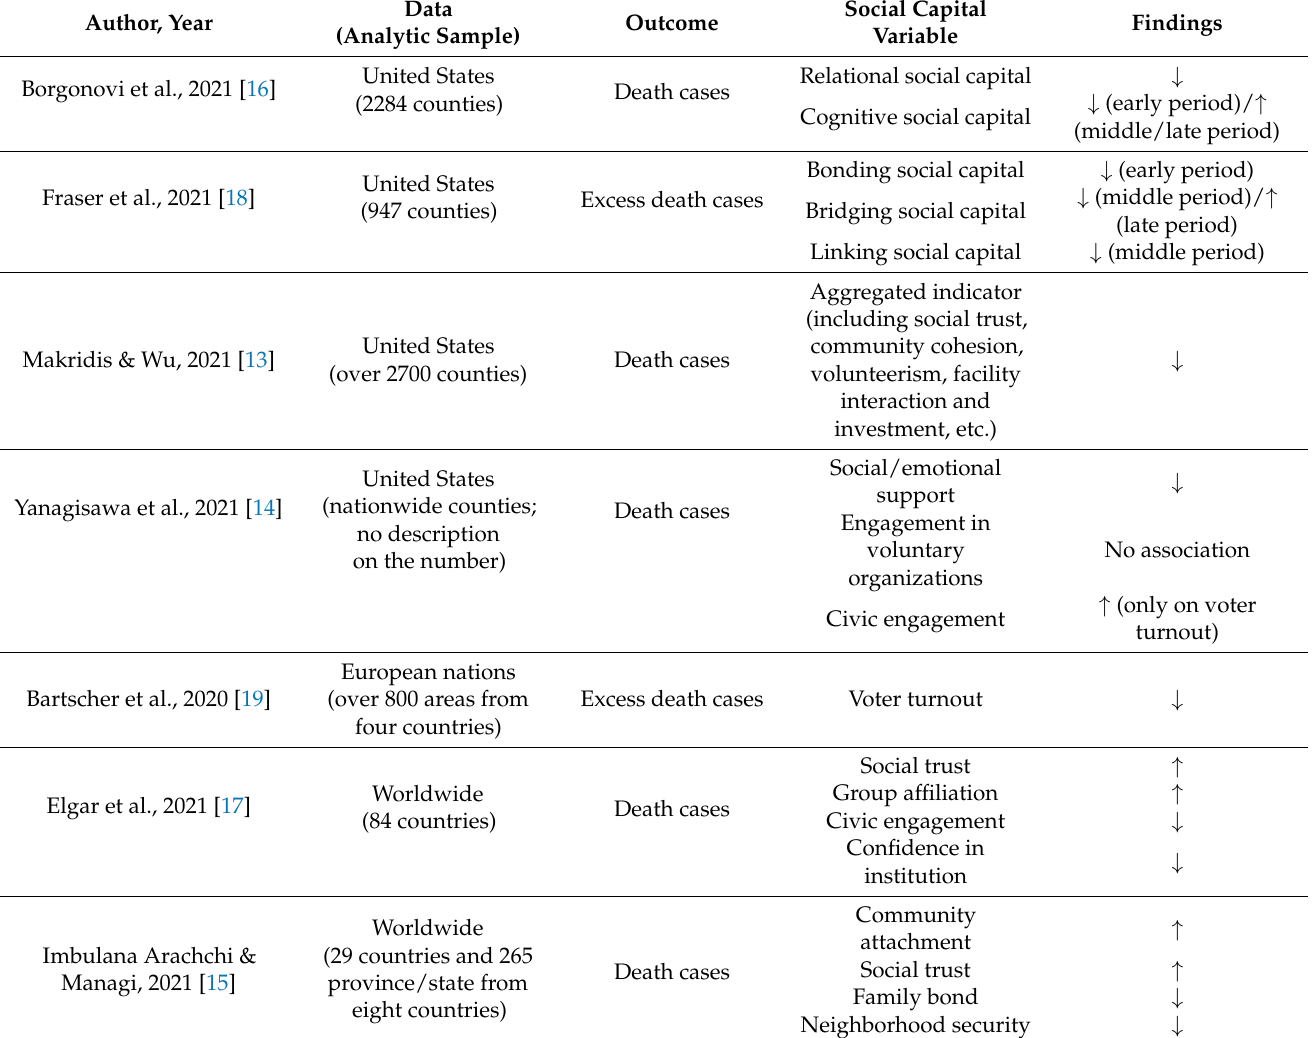
Table 1. Previous findings on the relationship between social capital and COVID-19